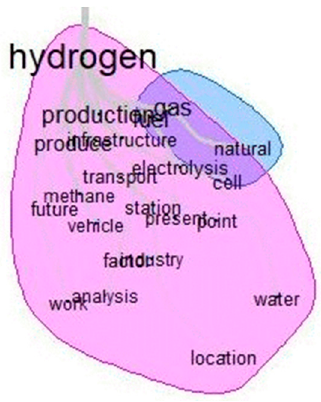
Figure 7. The set of words around the word “hydrogen”. Source: Own elaboration based on the analysis in the IRAMUTEQ software.